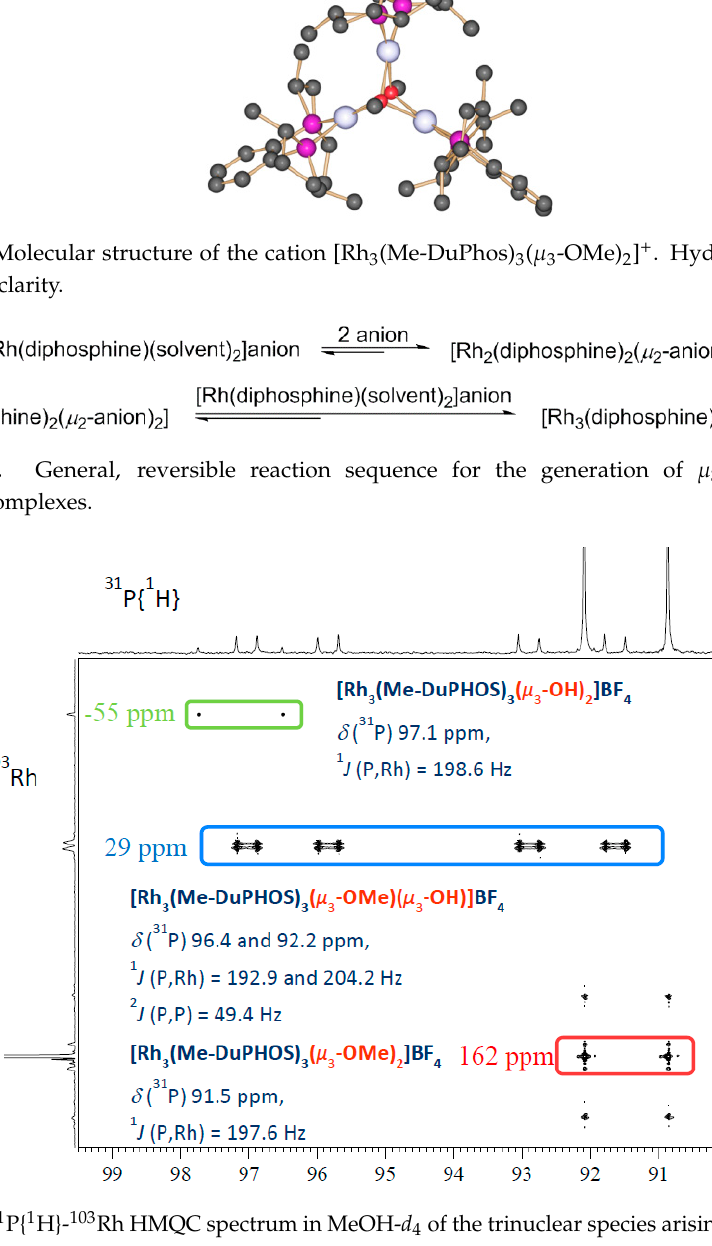
Figure 20. 31 P– 103 Rh correlation spectrum of a mixture of the solvent complex [Rh(DIPAMP)(MeOH) 2 ]BF 4 (0.02 mmol) and 100 μ L [2-(3-methoxyphenyl)-cyclohex-1-enylmethyl]-dimethylamine (0.4 mmol). The signals highlighted in red and blue correspond to the ( µ 3 -OMe) 2 and ( µ 3 -OMe)( µ 3 -OH) bridged trinuclear